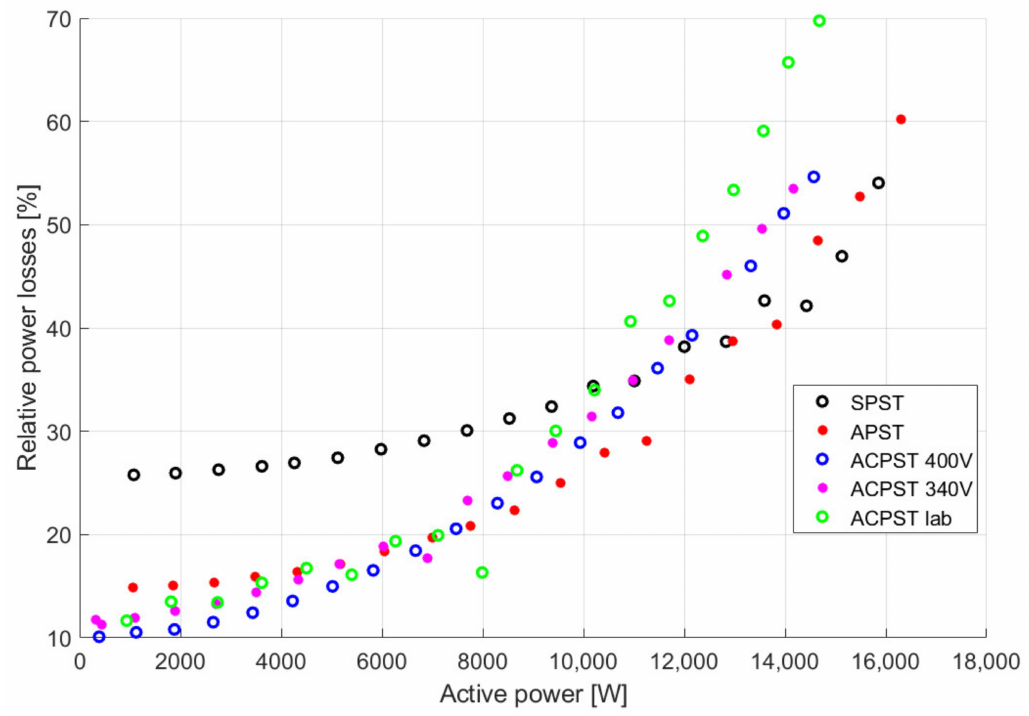
Figure 11. Relative power losses of each analyzed PST in a transmitted active power